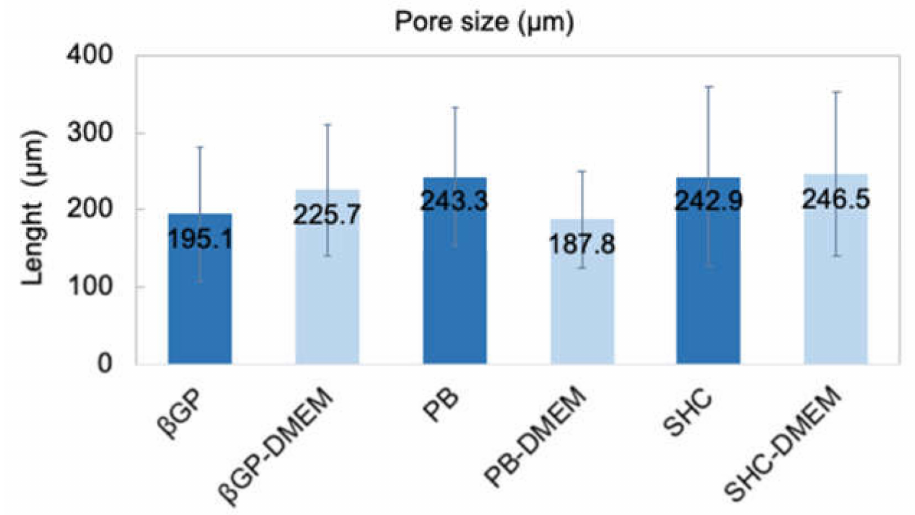
Figure 7. Average pore size of three hydrogel formulations ( β GP-PB-SHC) with and without the addition of